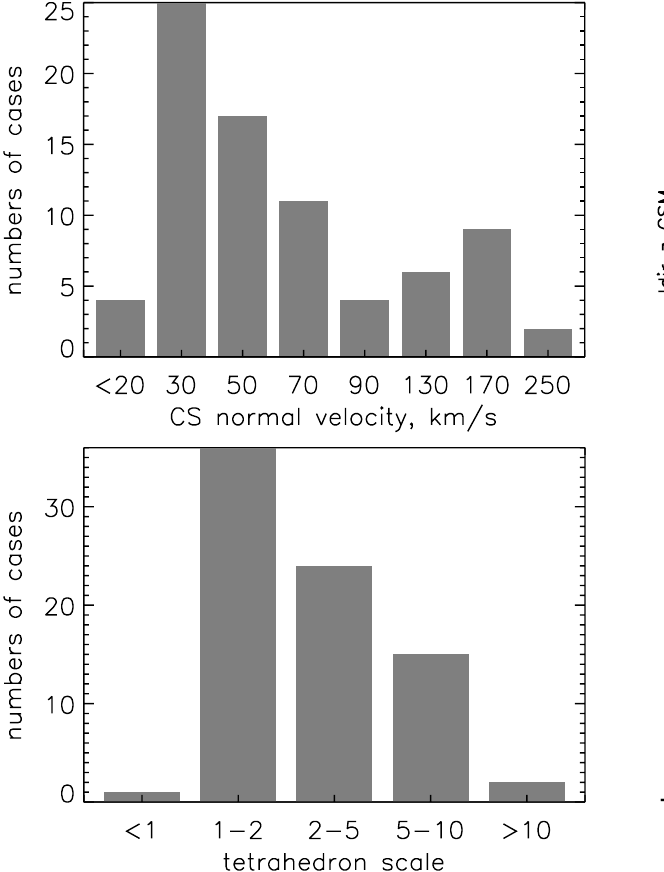
Fig. 6. Occurrence rates of the current sheet normal velocity ( V n , from timing) and estimated scales s = V n · τ , where τ is a crossing duration, normalized to characteristic tetrahedron scale a .